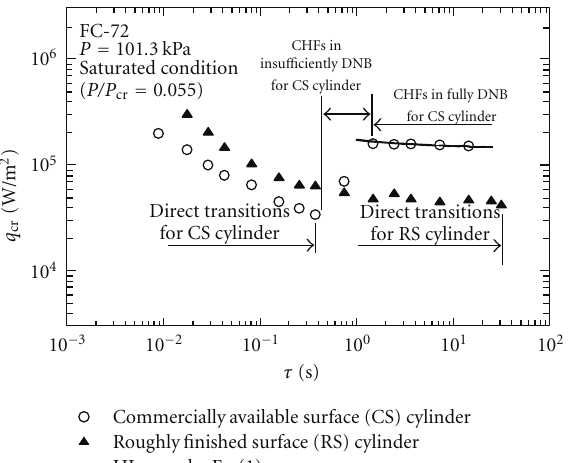
Figure 11: The relation between q cr and τ at atmospheric pressure in saturated FC-72 depending on cylinder surface roughness.